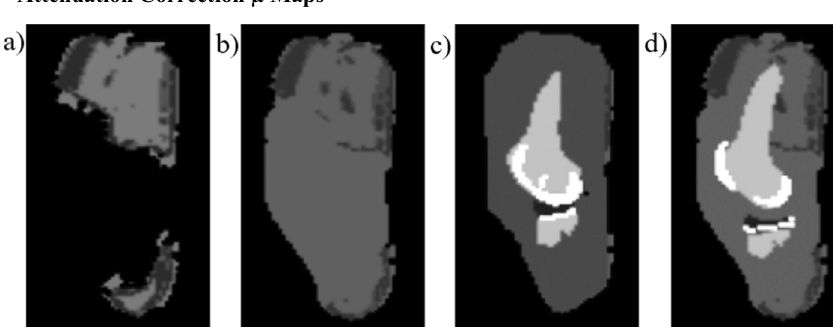
Fig. 2 Attenuation correction µ maps generated in four ways of varying complexity. a Single slice of the original 2-point Dixon, b simple tissue, c alternative model, and d accurate model µ